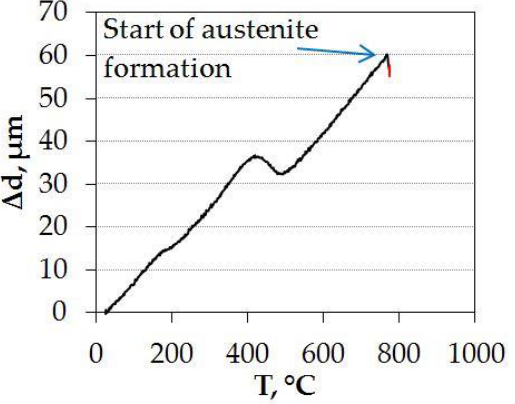
Figure 2. Dilatometric curve obtained during heating and soaking a specimen to the deformation temperature on a Bähr MDS 830 machine.